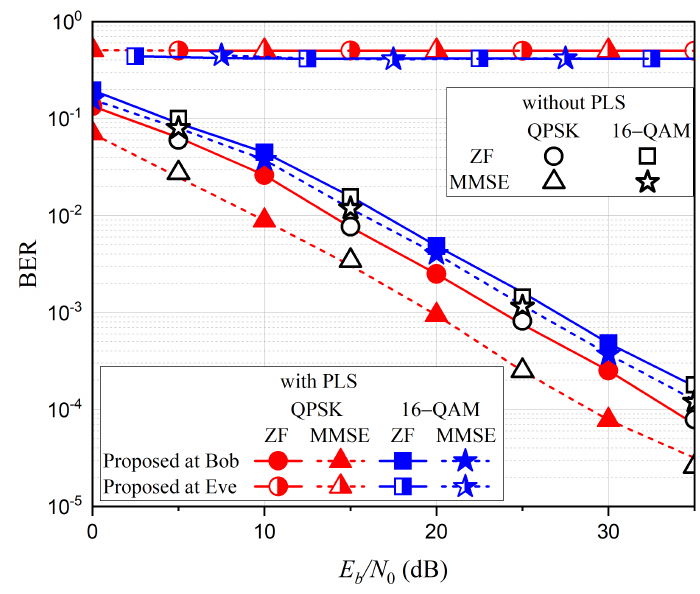
Figure 3. BER performance comparison for various SM schemes.